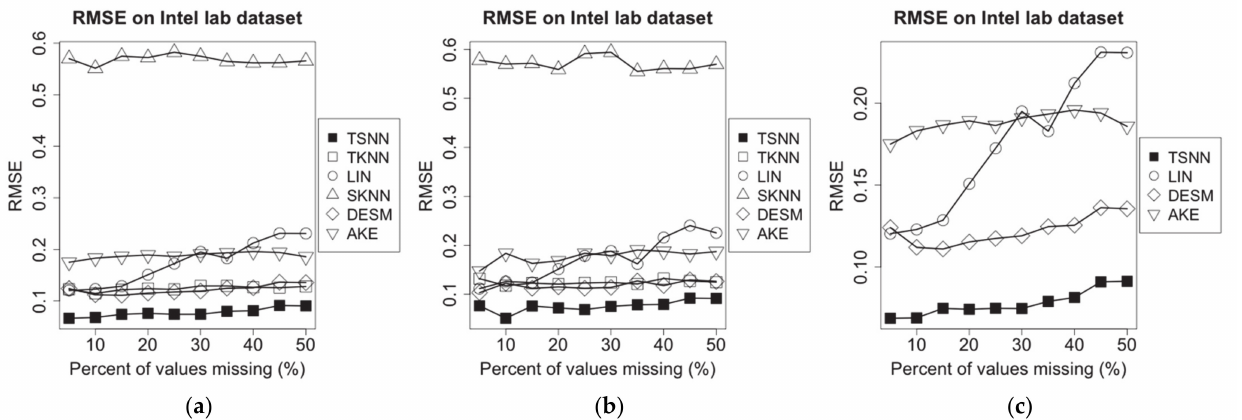
Figure 8. RMSE of imputation algorithms on humidity data of Intel lab dataset for the three scenarios: ( a ) humidity NA and temperature not NA, ( b ) humidity NA and temperature 50% NA and ( c ) humidity NA and temperature